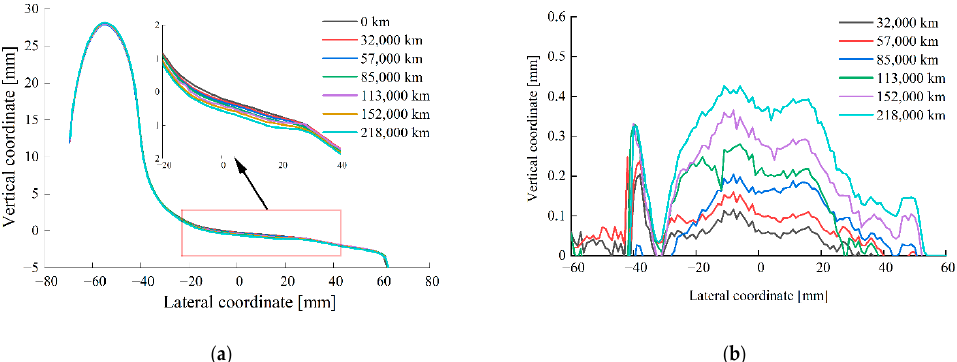
Figure 3. Wheel profiles and wear distribution of the Line B: ( a ) wheel tread profiles; ( b ) wheel wear distribution.